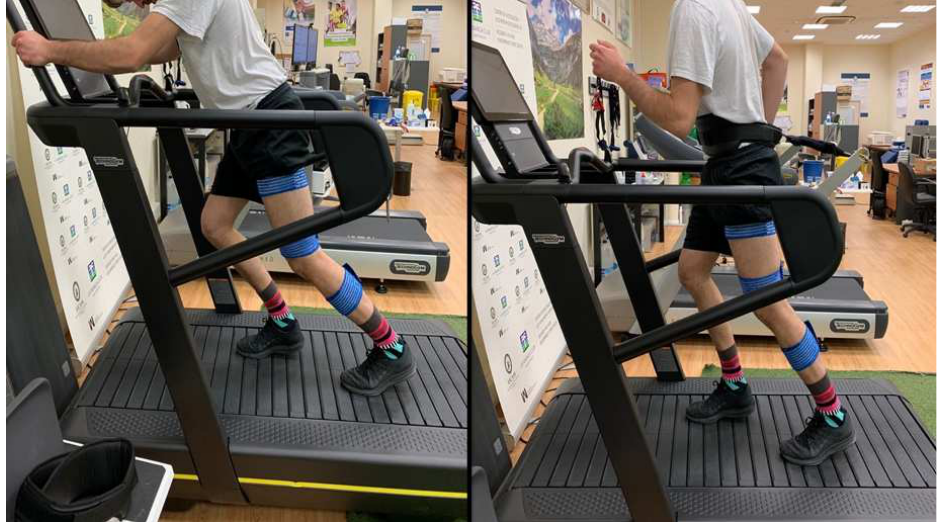
Figure 1. (A, left panel) Sled-push and, (B, right panel) resisted-parachute sprinting on the SR ® treadmill. 2.1. Subjects 2.1. Subjects Nine male amateur rugby union players (age 21.3 ± 4.3 years, mass 75.8 ± 10.2 kg, Nine male amateur rugby union players (age 21.3 ± 4.3 years, mass 75.8 ± 10.2